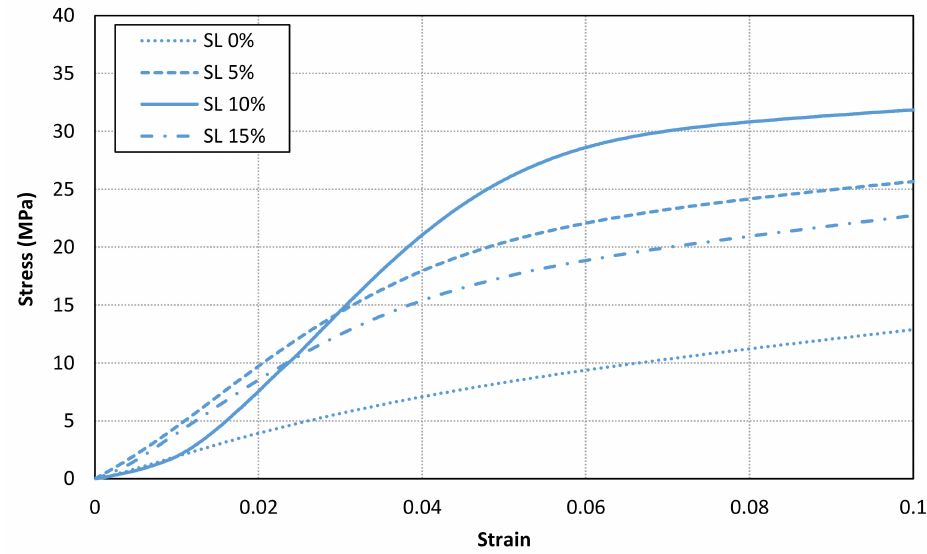
Figure 11. Stress-strain curves for a representative compression sample for each solid load content for X orientation.